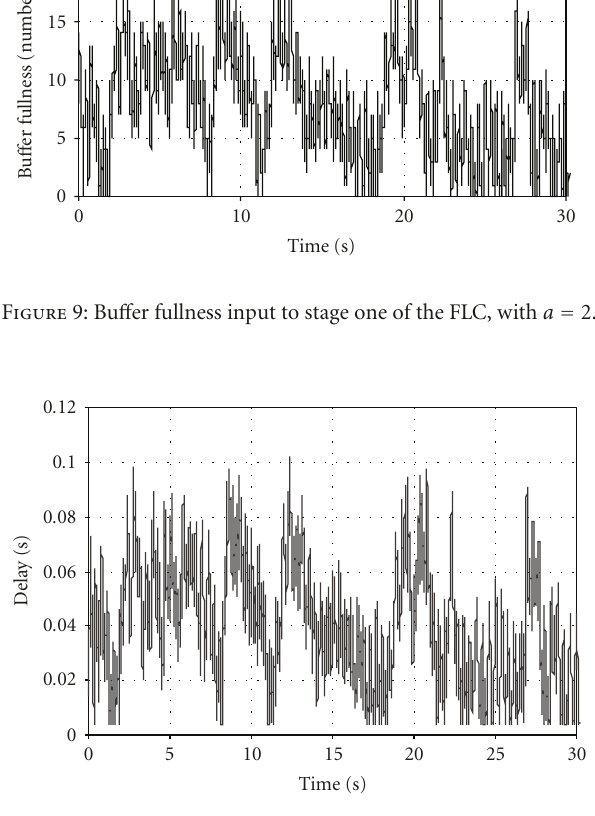
After the removal of deadline expired packets, through operation of the deadline aware bu ff er (DAB) described in Section 3.4, the bu ff er fullness input to stage one of the send bu ff er oscillates around a level well below the 50-packet maximum, Figure 9. Head-of-line packet delay, Figure